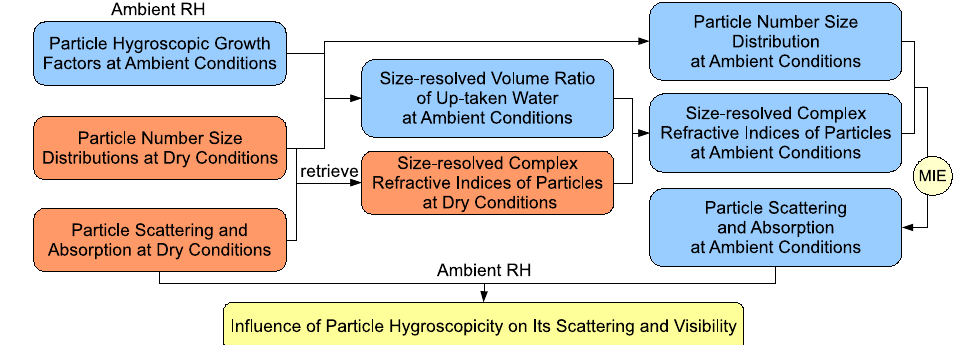
Fig. 3. Simulating aerosol properties at ambient conditions using the optical